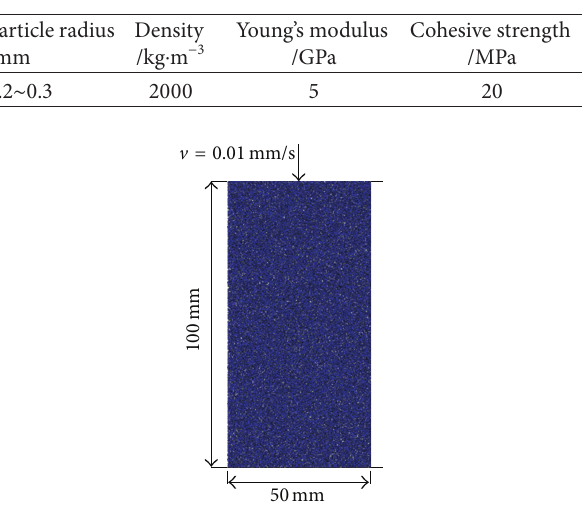
Figure 2: Generated model for uniaxial compressive